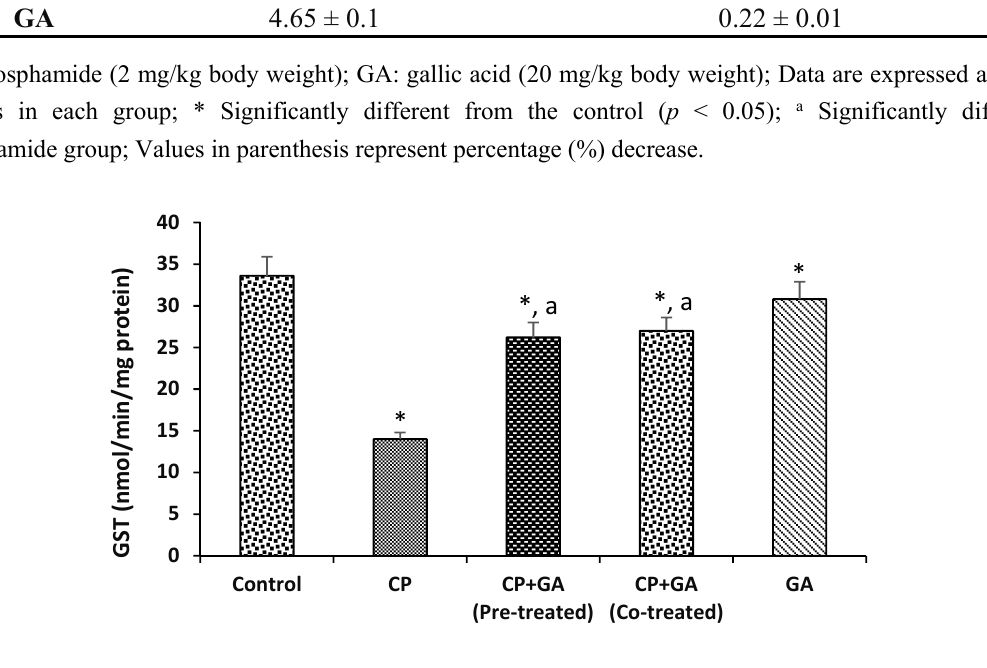
Figure 2. Protective effects of gallic acid on cyclophosphamide induced changes in the activity of hepatic glutathione- S -transferase (GST) in rats. CP =